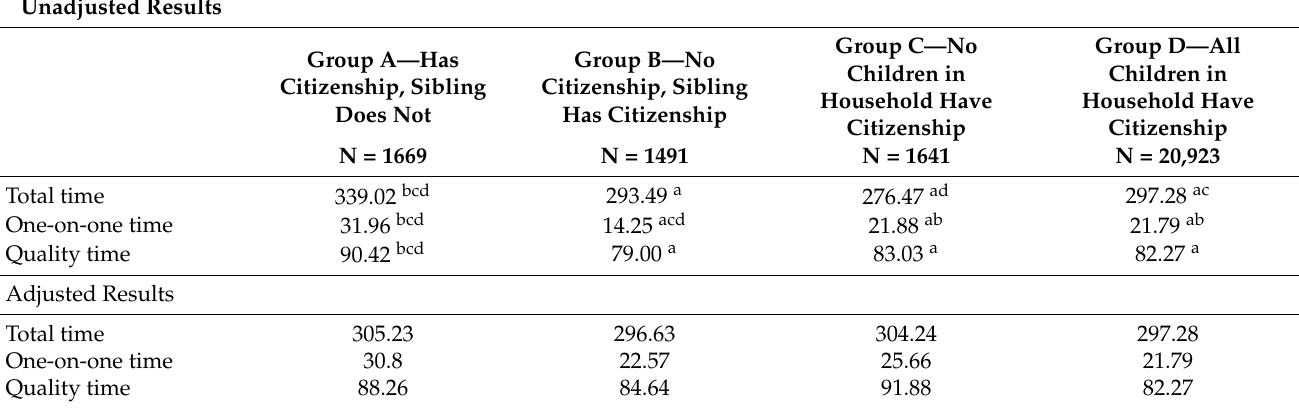
Table A3. Minutes Per Day of Parental Time Investments in Each Child In Families with Two or More